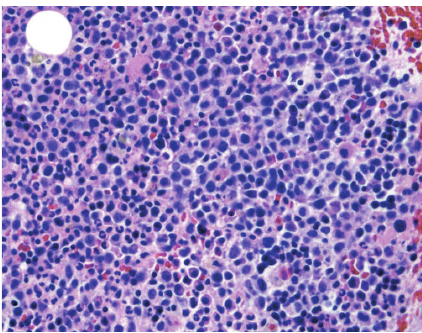
Figure 3: Hypercellular bone marrow with aggregates of large im- mature mononuclear cells (H & E